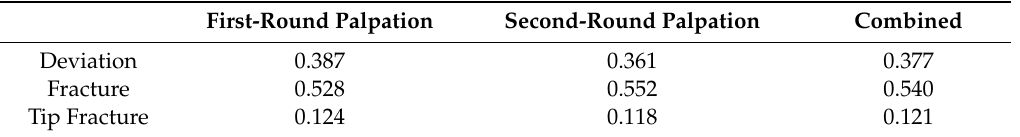
Table 3. Kappa values for the inter-reliability of four evaluators indicating agreement in the first, second, and combined rounds of palpation for keel bone deviations, fractures, and tip fractures.